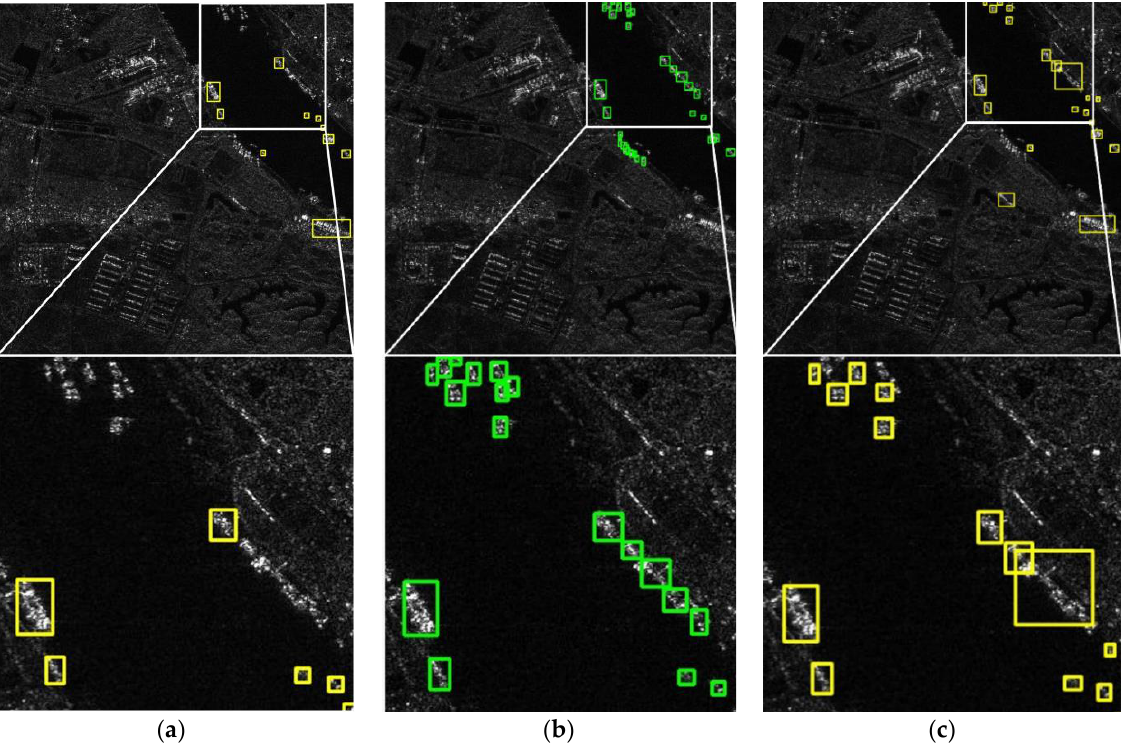
Figure 9. Results in the first river scenario, where the green boxes represent the ship positions marked in the dataset and the yellow boxes represent the detection results inferred by the detection model. ( a ) inference by YOLOX_L, ( b ) the real target frame marked in the dataset, and ( c ) inference by YOLO-SD.